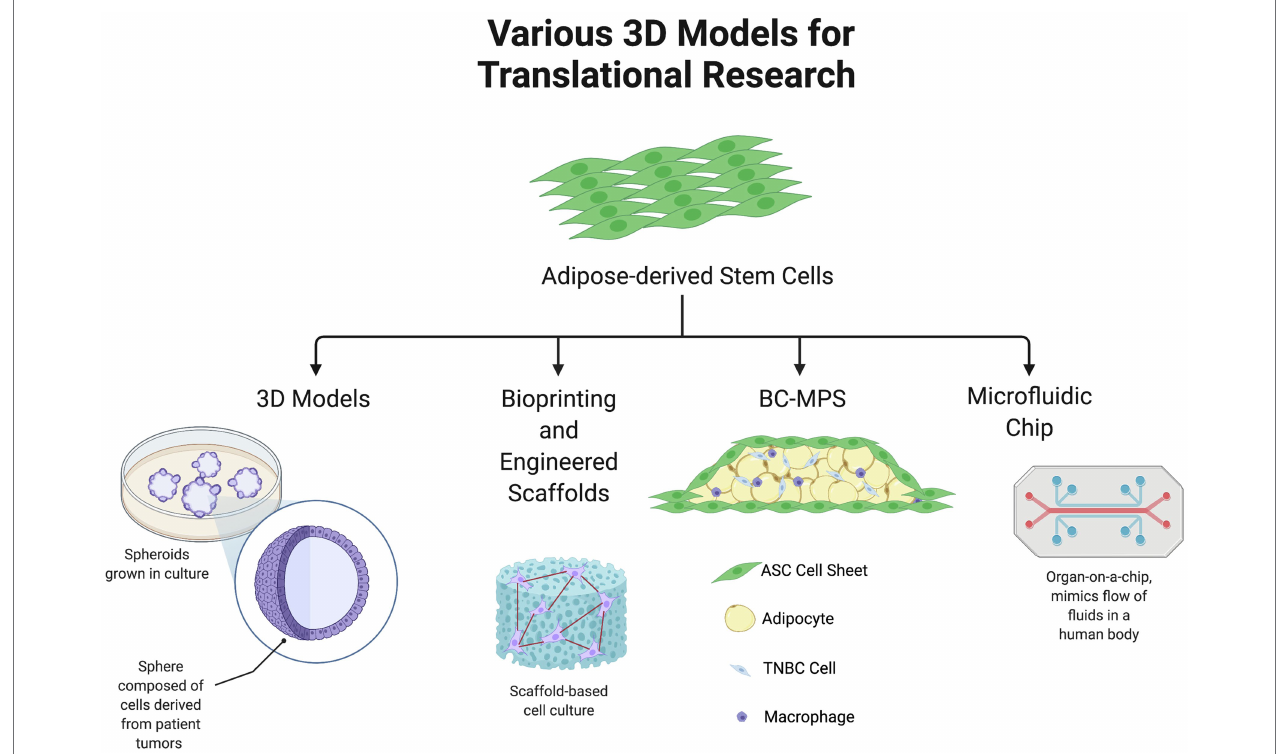
FIGURE 2 | Adipose-derived stem cells in translational research models. Adipocytes and ASCs have many applications in 3D laboratory models of breast